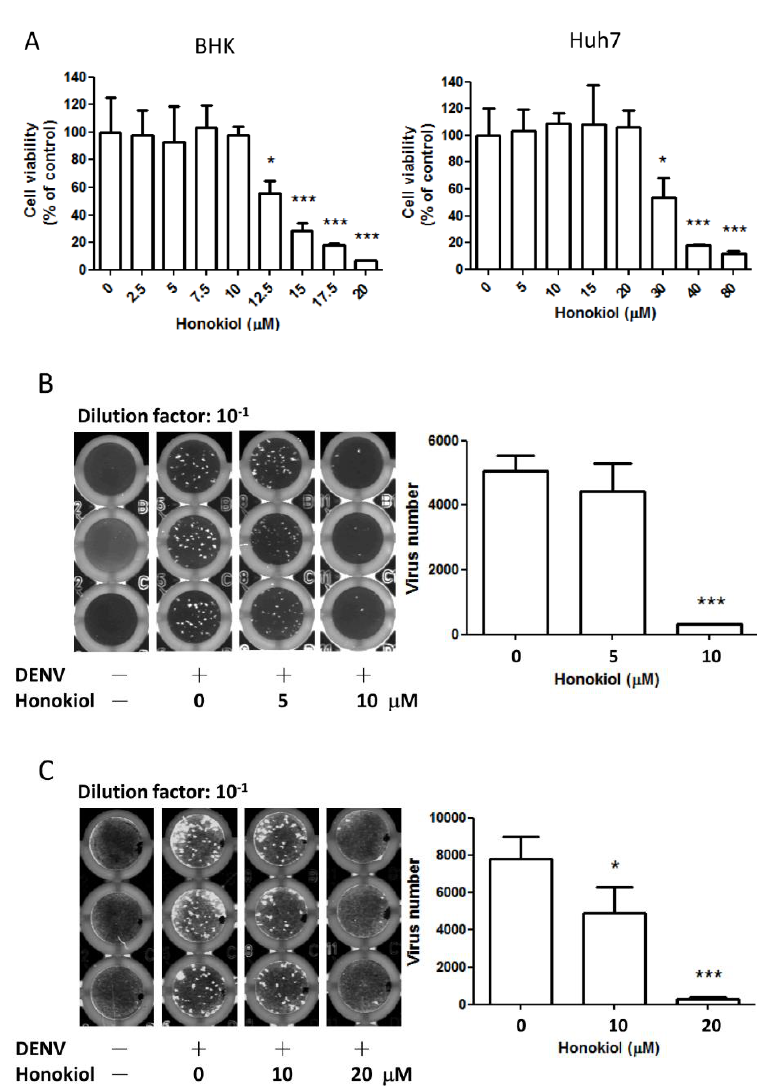
Figure 2. Honokiol decreases dengue virus production. ( A ) The cytotoxicity of honokiol on BHK and Huh7 cells was measured by MTT assay. Various concentrations of honokiol were applied to cells for 48 h; ( B , C ) Infectious DENV-2 particles released from DENV-infected, mock/honokiol-treated ( B ) BHK and ( C ) Huh7 cells were determined by fluorescence focus assay. Quantification of the virus number was calculated by (fluorescence focus units) × (dilution factor) × (total supernatant volume) and plotted as a bar chart. Data indicate the average value of triplicates (mean ± SD). * p < 0.05; *** p < 0.001, as compared with the control.